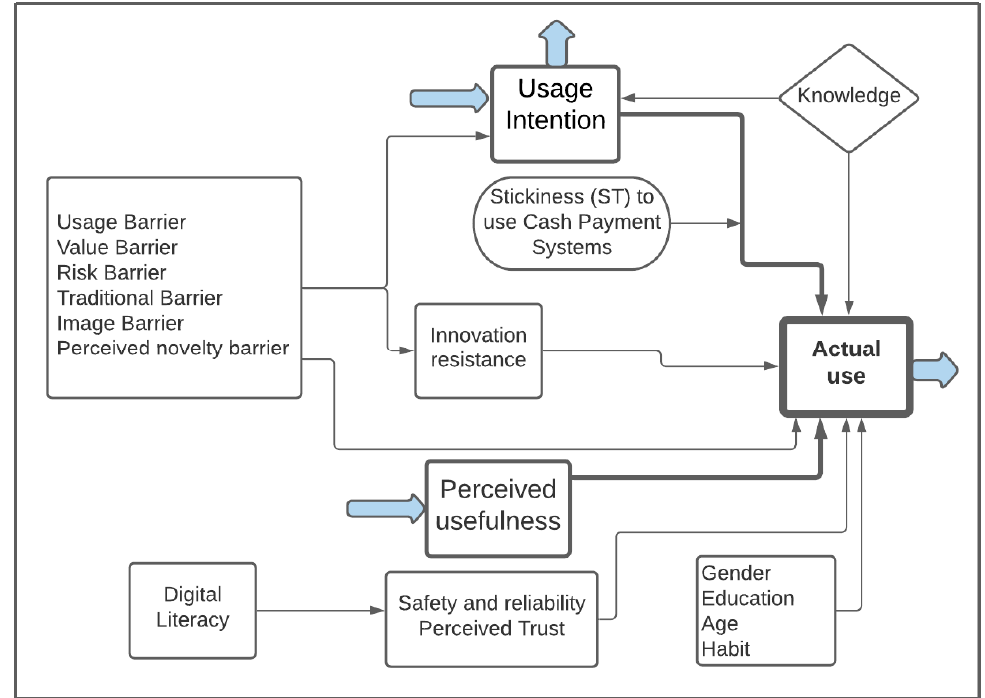
Figure 5. The actual use model of electronic payments.